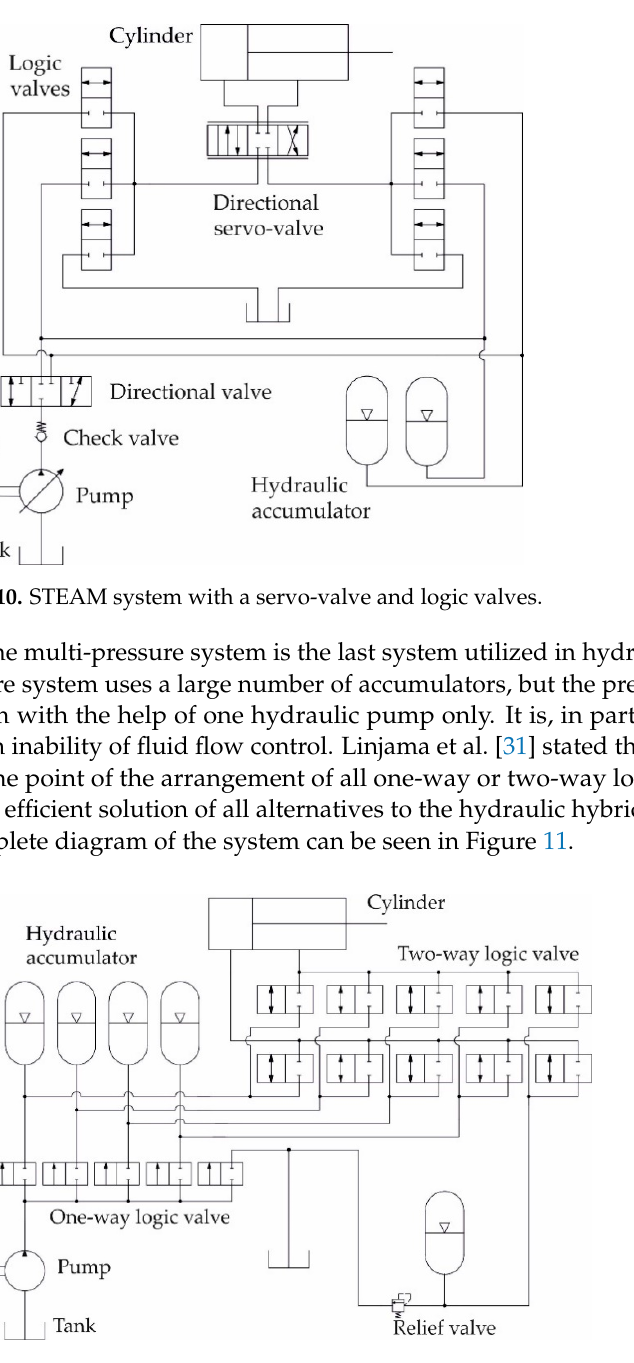
Figure 11. Multi-pressure system.